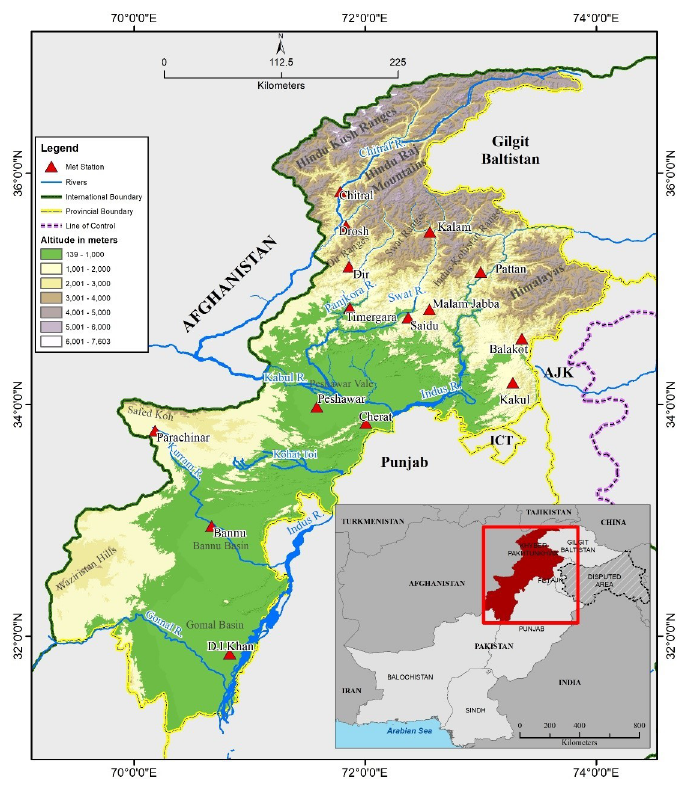
Fig 1. Khyber Pakhtunkhwa and location of meteorological stations in the study